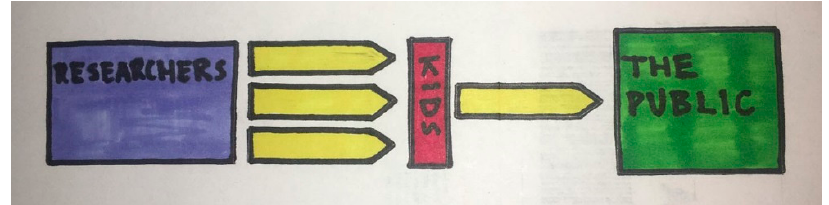
Figure 3. Information flow from Researchers to The Public. Kids—reviewers act as a filter to focus the information that researchers want to share with the public.